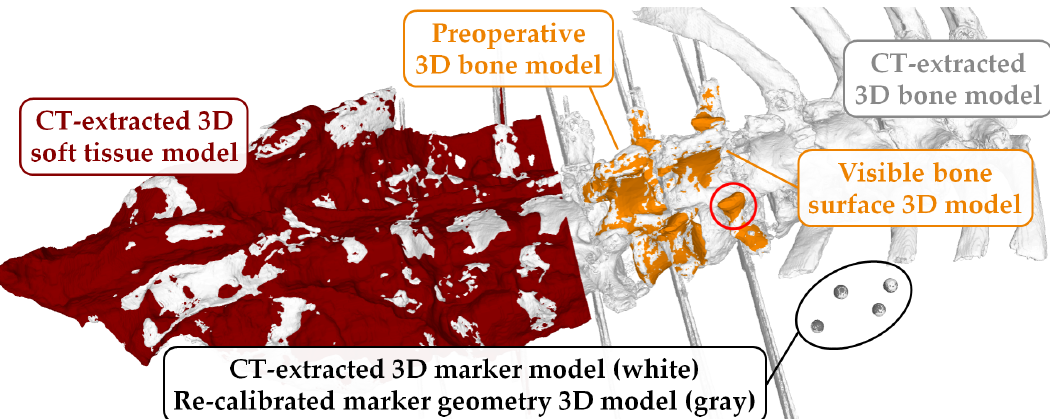
Figure 5. CT-extracted 3D marker model for L1 (white spheres) aligned to re-calibrated marker geometry 3D model combined from generic sphere 3D models of true size (gray); preoperative 3D bone model for L2 (orange) aligned to CT- extracted 3D bone model (white); CT-extracted 3D soft tissue model (red, cut off around L3 for visualization purposes) and visible bone surface 3D model for L1 (result when subtracting 3D soft tissue model (red) from preoperative 3D bone model ). Red circle: area around the facet joint and mamillary process, which was present in the preoperative 3D bone models , but mostly absent in specimens 2–10 (history of spinal fusion performed within the scope of another